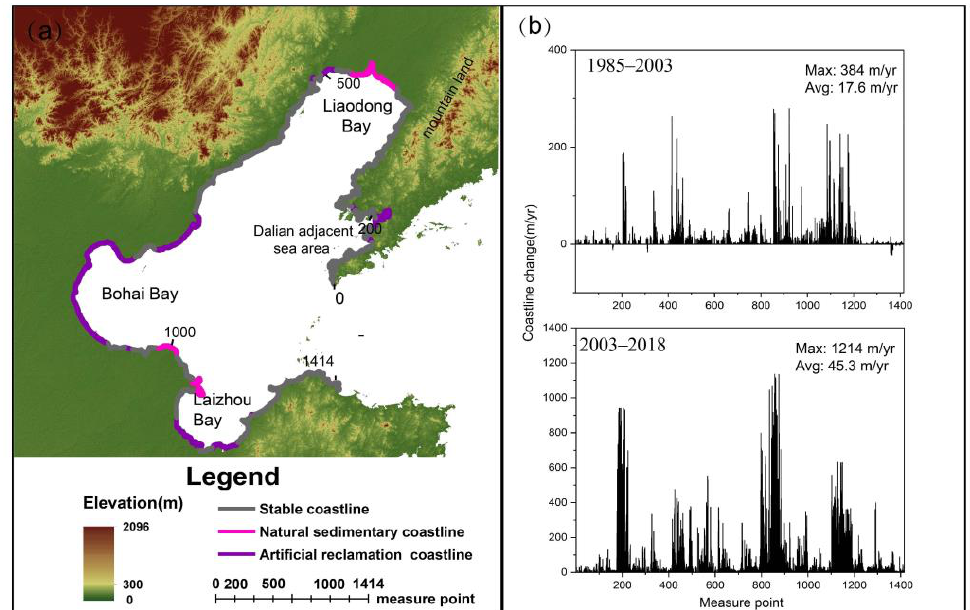
Figure 8. Coastline changes recorded over 1985 – 2003, 2003 – 2011, and 2003 – 2018. Topography of the land extracted from the remote sensing image ( a ); a total of 1414 coastline change rates, each corre- sponding to a DSAS transect ( b